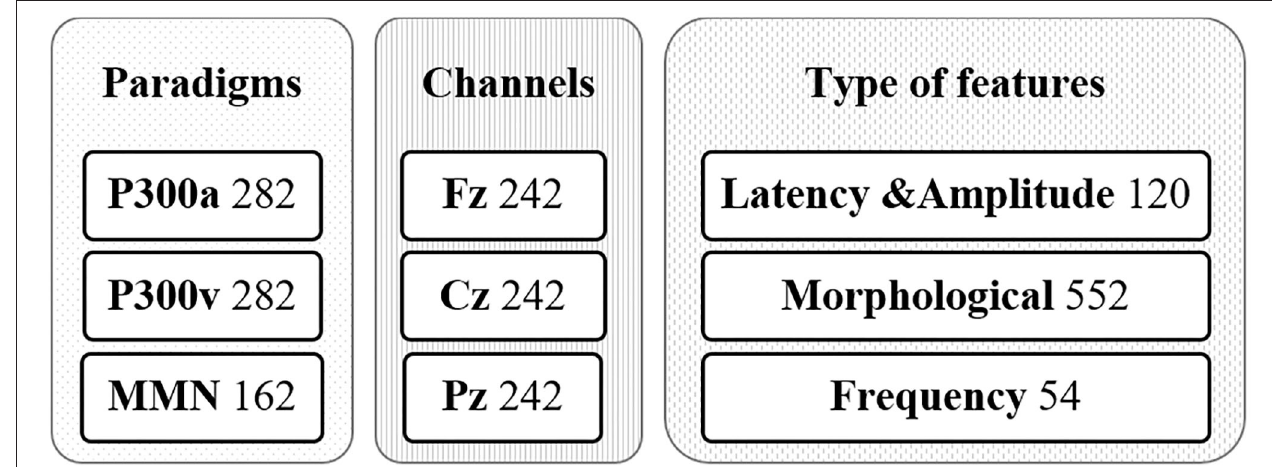
FIGURE 3 | Grouping input data (726 features) in three possible kernel combinations according to the feature space